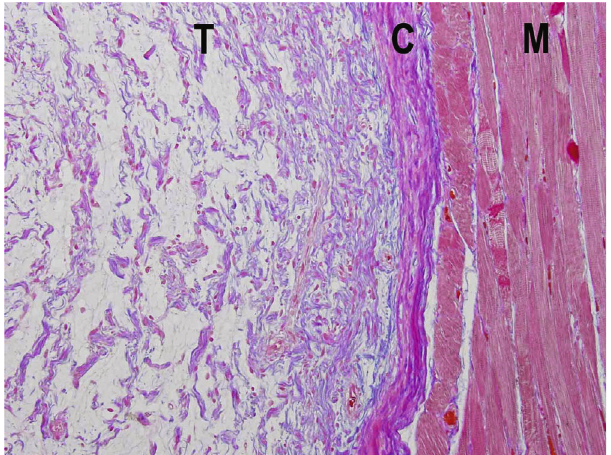
Figure 4: Photomicrograph showing stellate and spindle-shaped cells with no atypia in the abundant myxoid extracellular matrix (hematoxylin – eosin stain, × 100). T: tumor, C: fi brous capsule, M: muscle of the tongue.